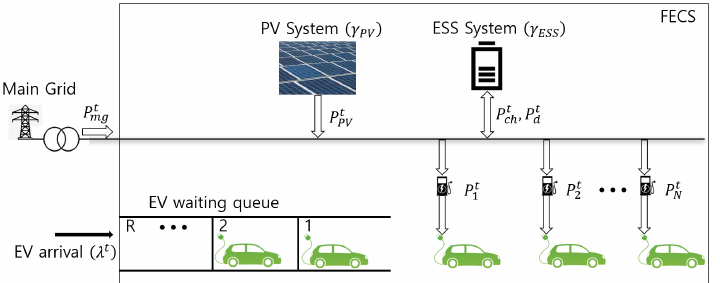
Figure 1. An example of a grid-connected FECS integrated with the solar PV and ESS. Each fast charger n ∈ N can serve at most one EV during a time slot. The EV charging process starts at the beginning of a time slot and finishes at the end of the time slot. The FECS purchases power from the main grid or uses solar PV and ESS power to supply the EV charging demand. Considering that one day consists of { 1, ..., T } time slots, we set the duration of one time slot as 10 min, which resulted in T =